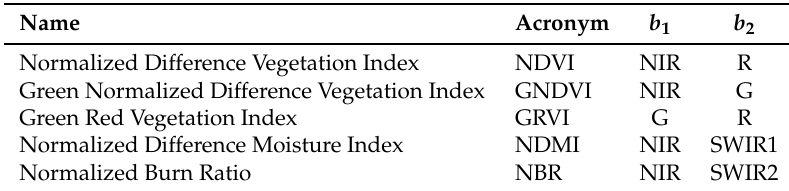
Table 2. Normalized Difference Spectral Index (NDSI) definitions using Equation (1), which were calculated for each satellite